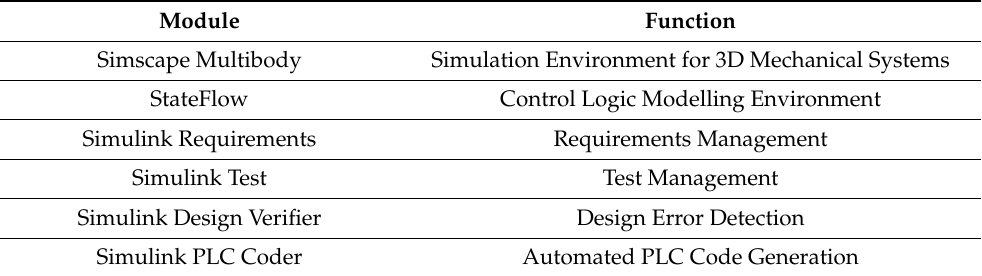
Table 1. Simulink modules and respective functions required for digital validation.